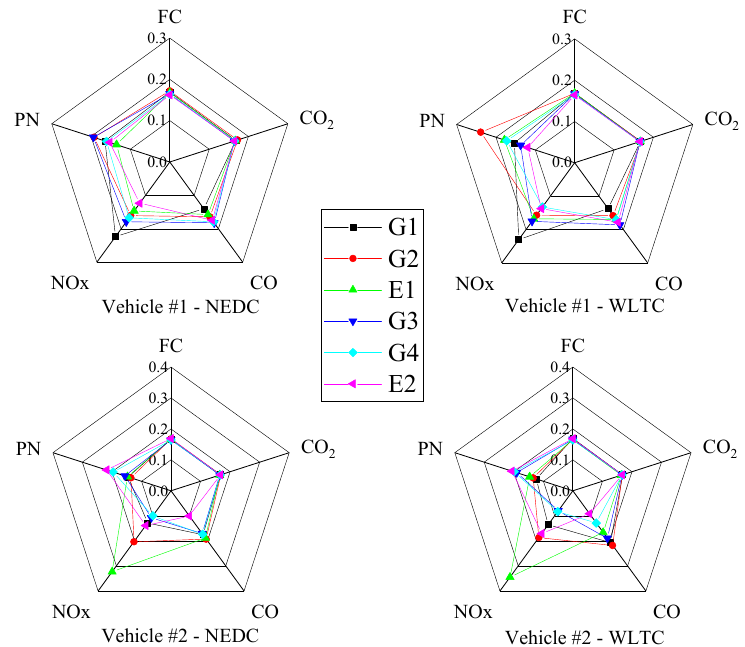
Figure 9. Radar chart of normalized pollutant emission factor.